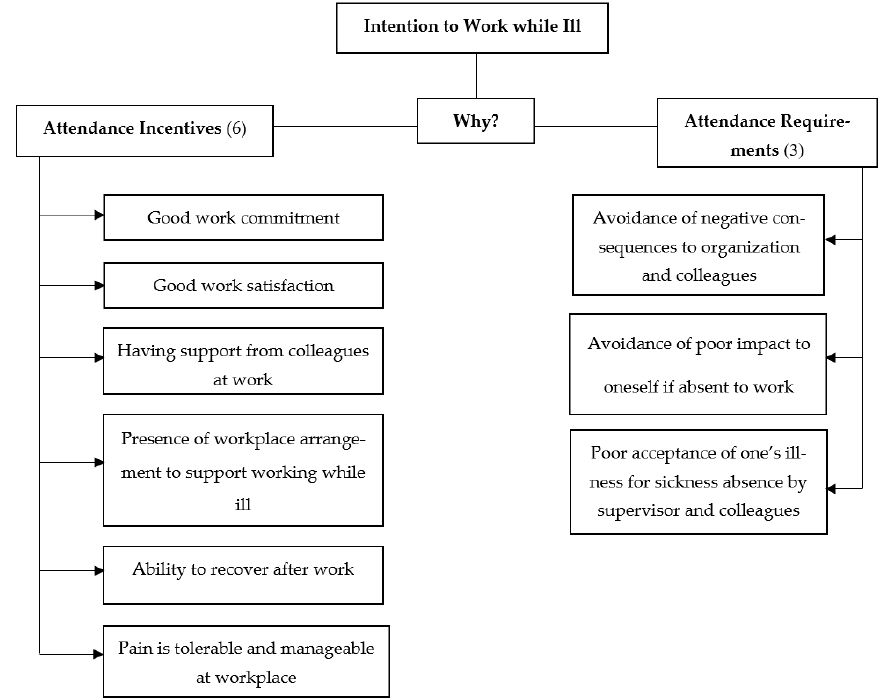
Figure 2. Thematic content of attendance incentives and attendance requirement themes for attending work while ill.